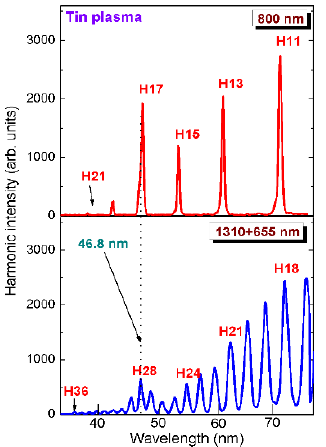
Figure 5. Spectral distribution of harmonics in 33–77 nm spectral range in the case of different pumps of Sn LIP. Upper panel: SCP (800 nm) using Laser1 when H17 ( λ = 46.76 nm) was enhanced in the vicinity of strong ionic transition. Bottom panel: OTC (1310 + 655 nm) using Laser2 when H28 was stronger than the adjacent harmonics.